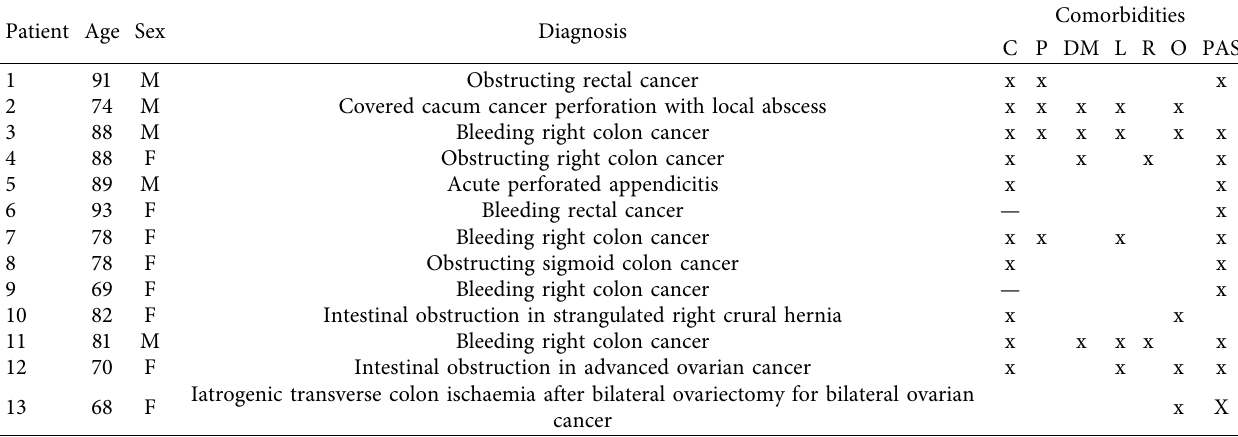
Table 1: Patients’ clinicopathological